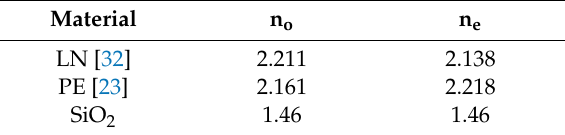
Table 1. Refractive indices of the material in simulation ( λ = 1.55 µ m).